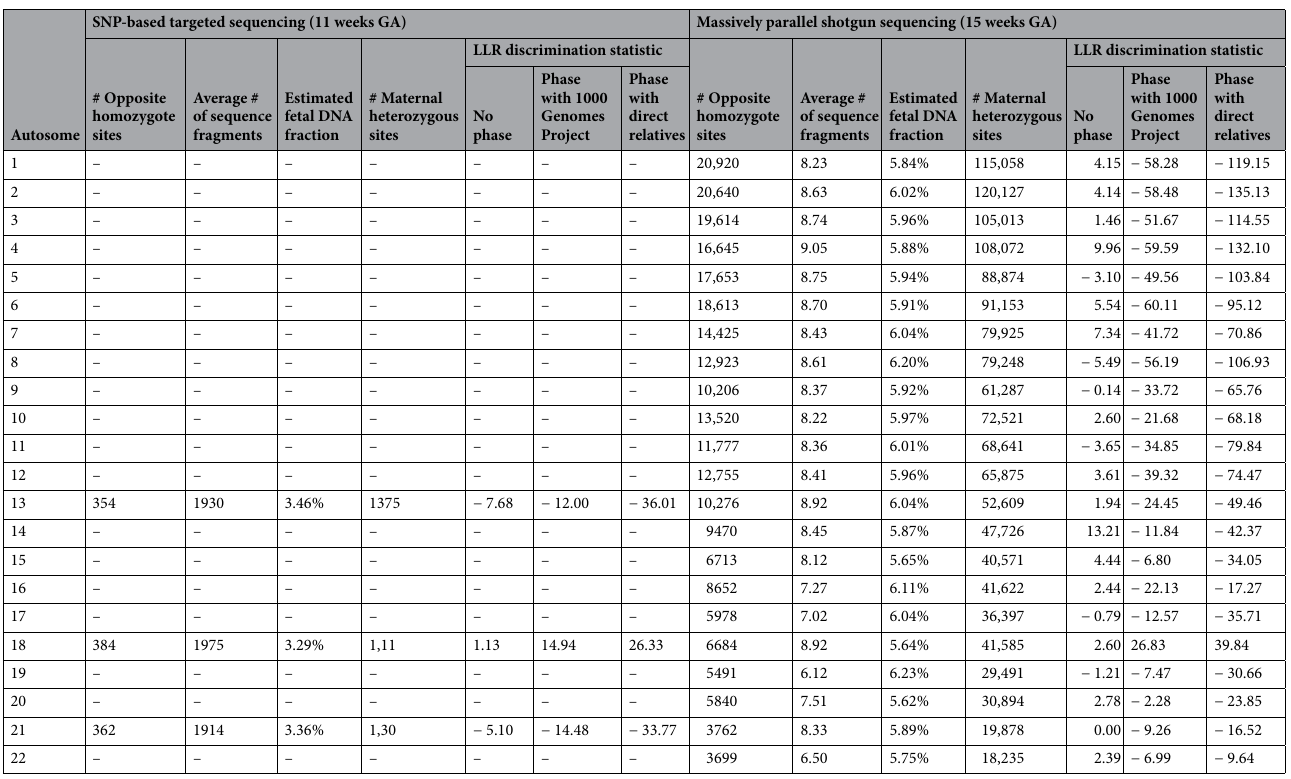
Table 1. Fetal DNA fraction estimates and discrimination statistics across autosomes. SNP-based analyses results for the targeted and MPSS data generated from the cfDNA of the plasma obtained from the